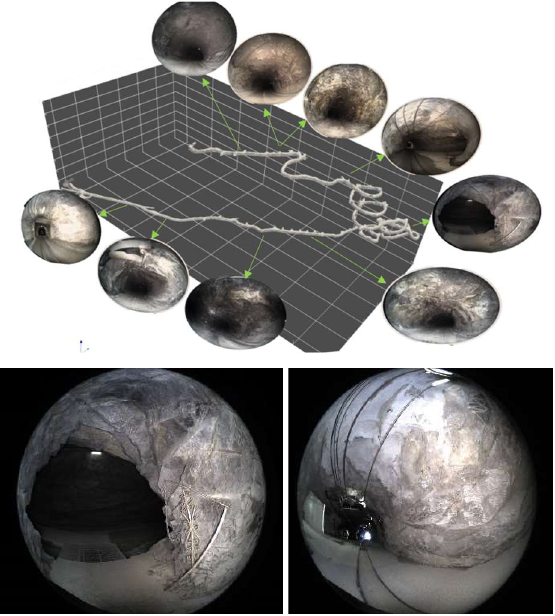
Figure 10. Example of the fisheye images extracted from the photogrammetric